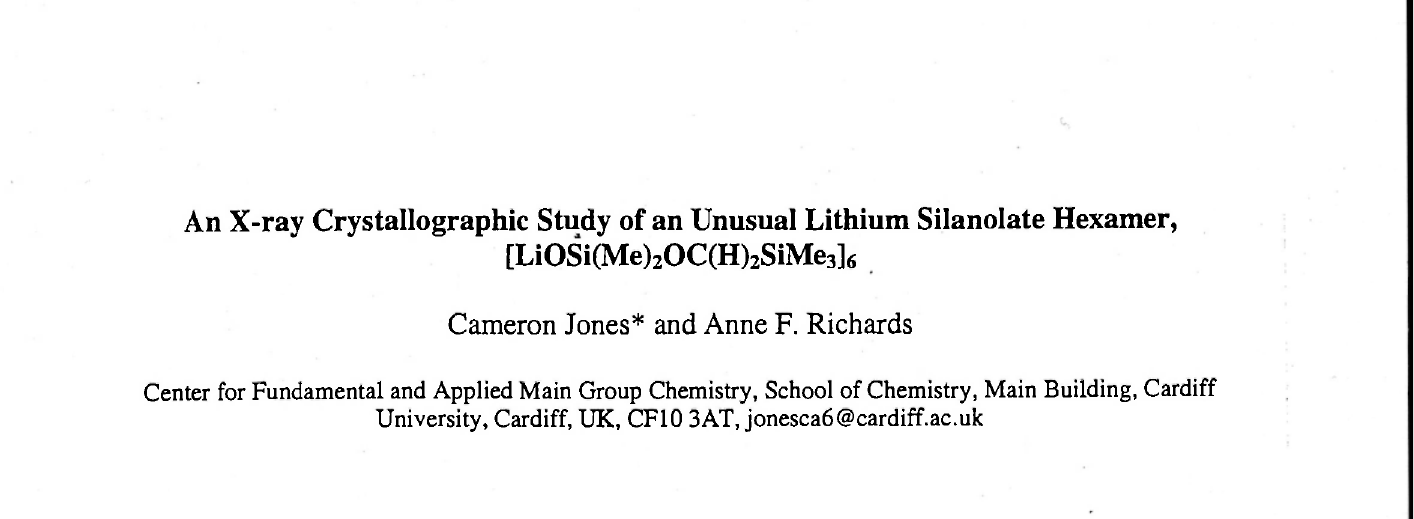
Figure 1. (a) Molecular structure of [LiOSi(Me) 2 OC(H )2SiMe 1 showing (b) the coordination geometry 3 ] 6 of its central Li 6 0 6 core (hydrogens omitted for clarity, 20% ellipsoids). Key geometric parameters (A, 0(1)-Li(l) 1.891(5), 0(1)-Li(2)' 1.924(5), 0(1)-Li(3)' 2.098(5), 0(2)-Li(3)' 2.024(5), 0(3)-Li(3)